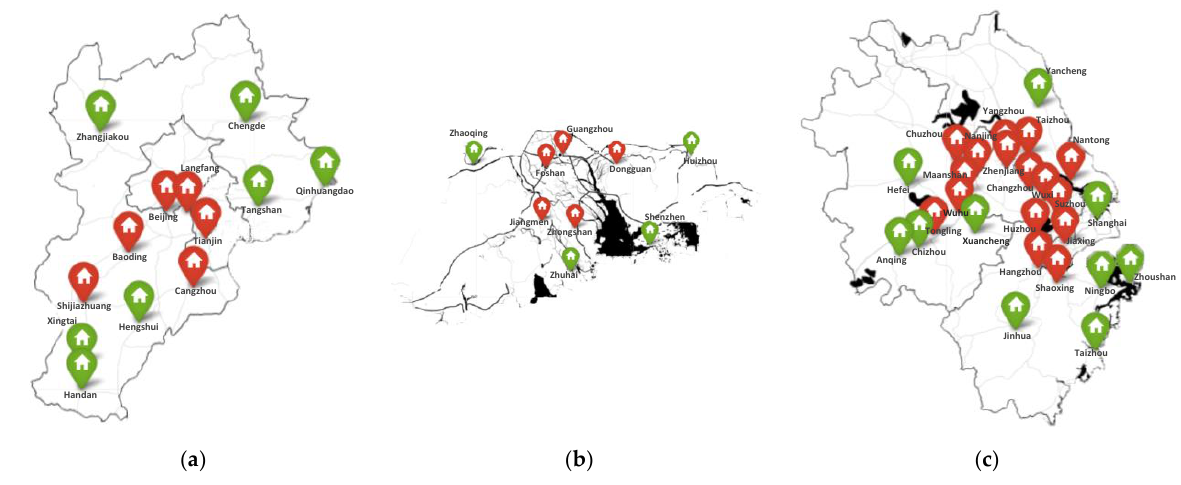
Figure 3. The location of each node in the networks of the three major urban agglomerations: ( a ) Beijing-Tianjin-Hebei; ( b ) Pearl River Delta; and ( c ) Yangtze River Delta.